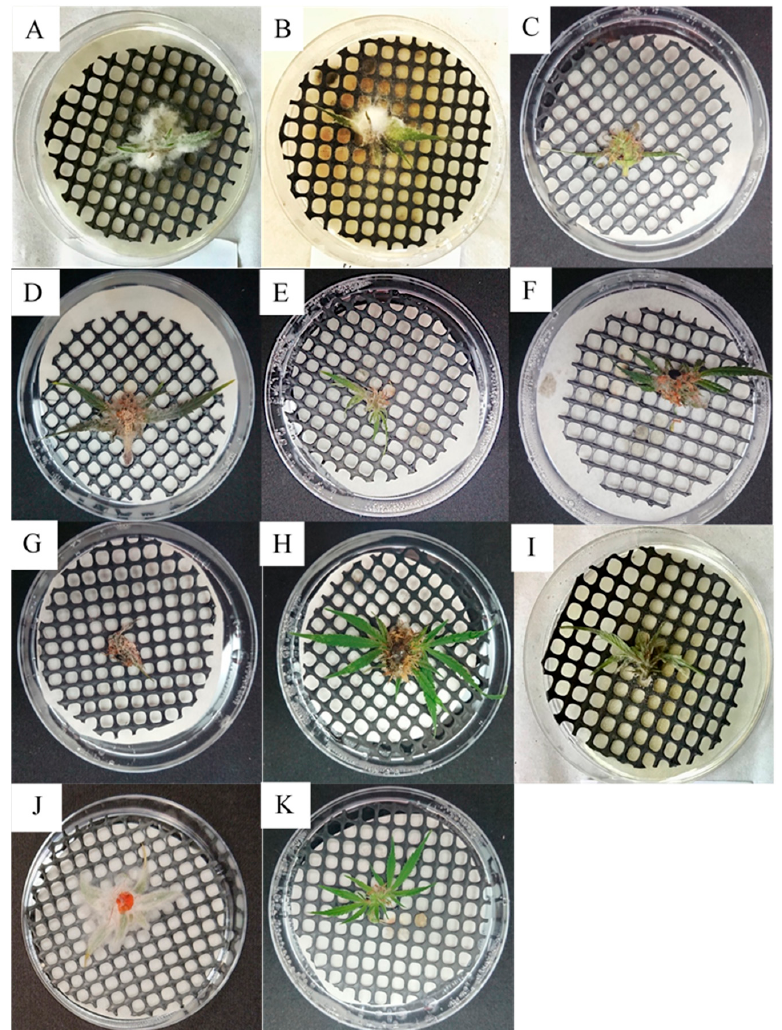
Figure 2. Koch postulate assays of detached MC inflorescence inoculated with ( A ) Alternaria alternata (isolate 22A); ( B ) Botrytis cinerea (isolate 63A); ( C ) Aspergillus flavus (isolate 49A); ( D ) Aspergillus westerdijkiae (isolate 71B); ( E ) Cladosporium tenuissimum (isolate 119B); ( F ) Cladosporium spp. (isolate 32A); ( G ) Penicillium citrinum (isolate 25A); ( H ) Penicillium steckii (isolate 33B); ( I ) Trichothecium roseum (isolate 16A); ( J ) Fusarium equiseti (isolate 10A); and ( K ) the control, inoculated with a sterile PDAC